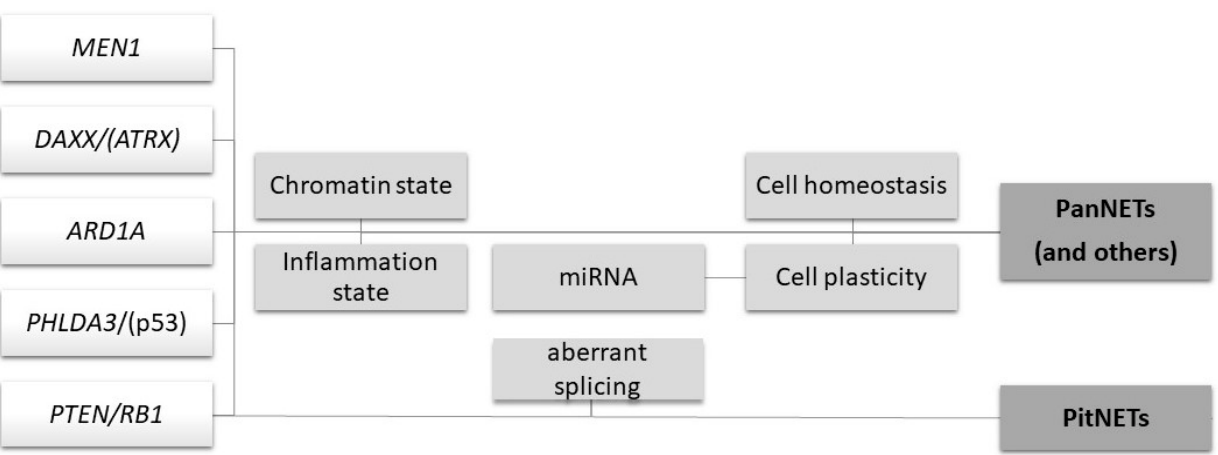
Figure 1. An overview of the main mechanisms involved in NENs’ tumorigenesis. This intersectional picture summarizes the tumorigenesis mechanisms described in the review. The first white part includes the main genes involved. The central light-gray part includes the consequences of the alterations of the involved genes or other intertwined players, e.g., miRNA or aberrant splicing (for PitNETs). The third dark-gray part includes the NENs as the final results of these processes.